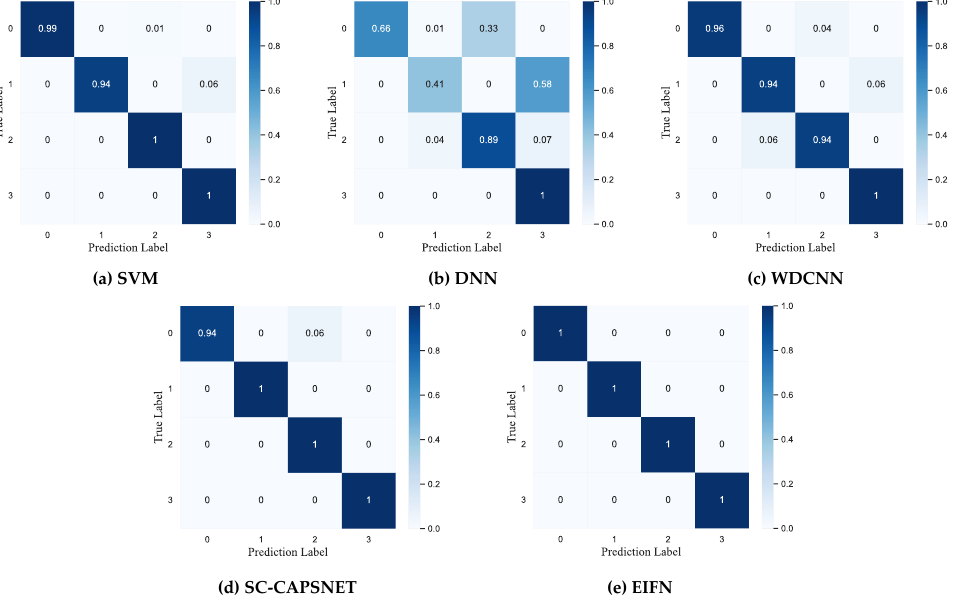
Figure 11. The confusion matrix of diagnostic accuracy on IMS. The abscissa is the prediction label, and the ordinate is the real label.